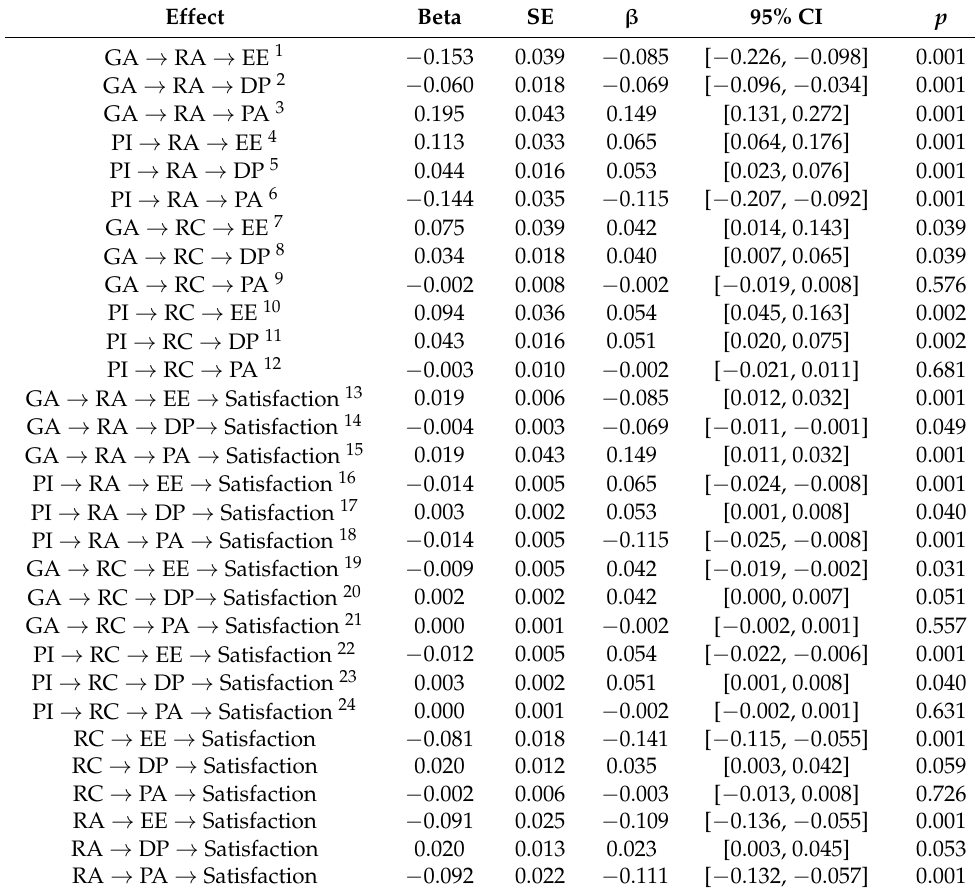
Table 3. Indirect effects of perceived vulnerability and role conflict and